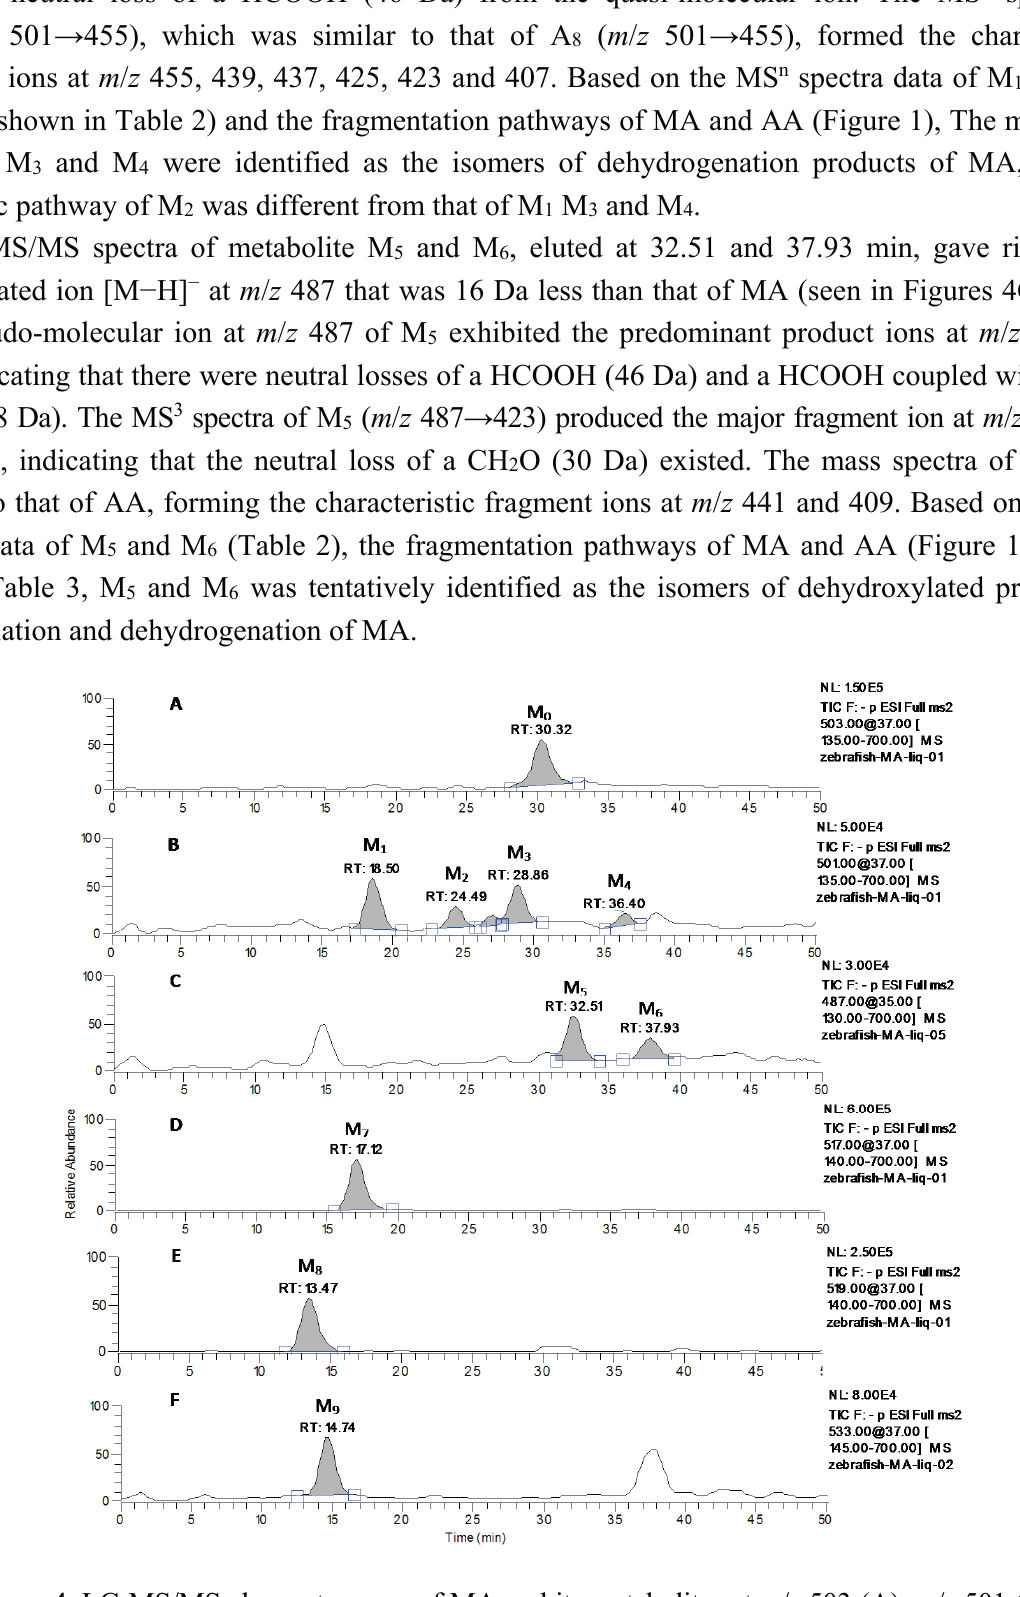
Figure 4. LC-MS/MS chromatograms of MA and its metabolites at m / z 503 ( A ), m / z 501 ( B ), m / z 487( C ), m / z 517 ( D ), m / z 519 ( E ), m / z 533( F ) with zebrafish